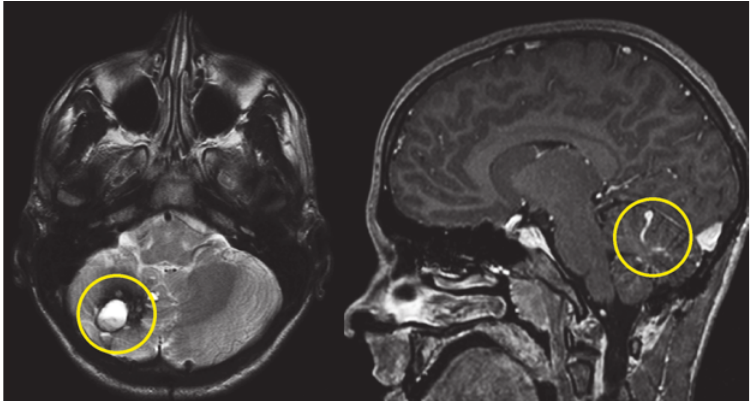
Cavernous malformation associated to a developmental anomaly. left:T2-weighted MRi demonstrating a right cerebellar haemorrhage from a cavernous angioma (different signal intensities revealing different states of haemorrhage). Right: Associated developmental anomaly of the venous drainage, often present with the cavernoma seen on a sagittalT1-weighted MRi with